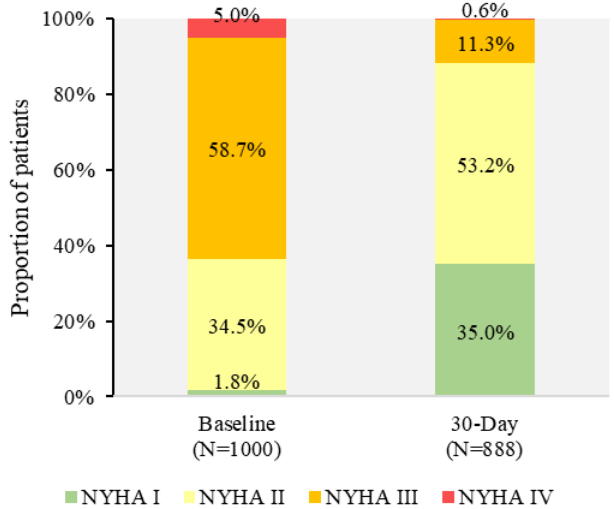
Figure 2. New York Heart Association functional class groups at 30 days (unpaired analysis).